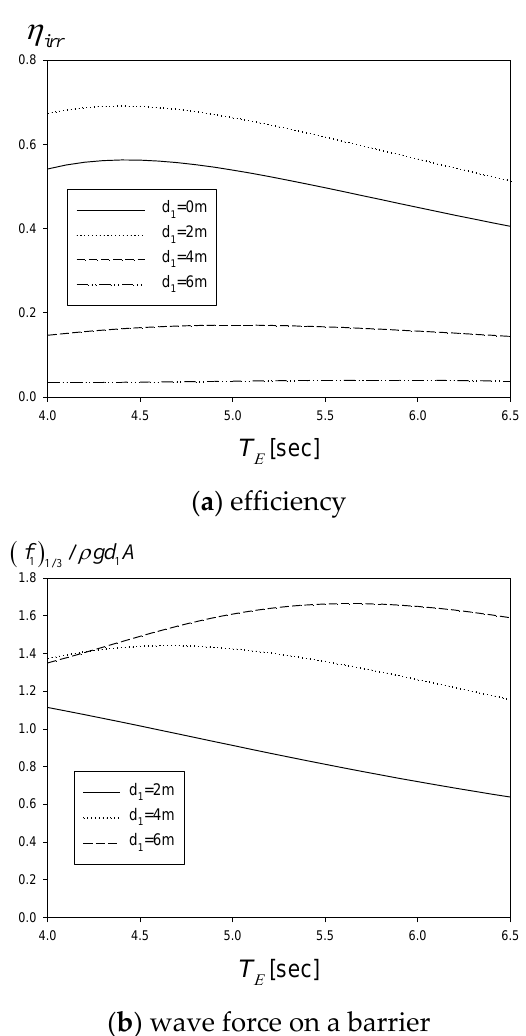
Figure 8. Conversion efficiency ( a ) and non-dimensional wave force ( b ) on a barrier as a function of the barrier height ( d 1 ) and energy period T E in irregular waves for h = 10 m, a = 3 m, d 2 = 3 m, b = 1.5 m, H 1/3 = 1